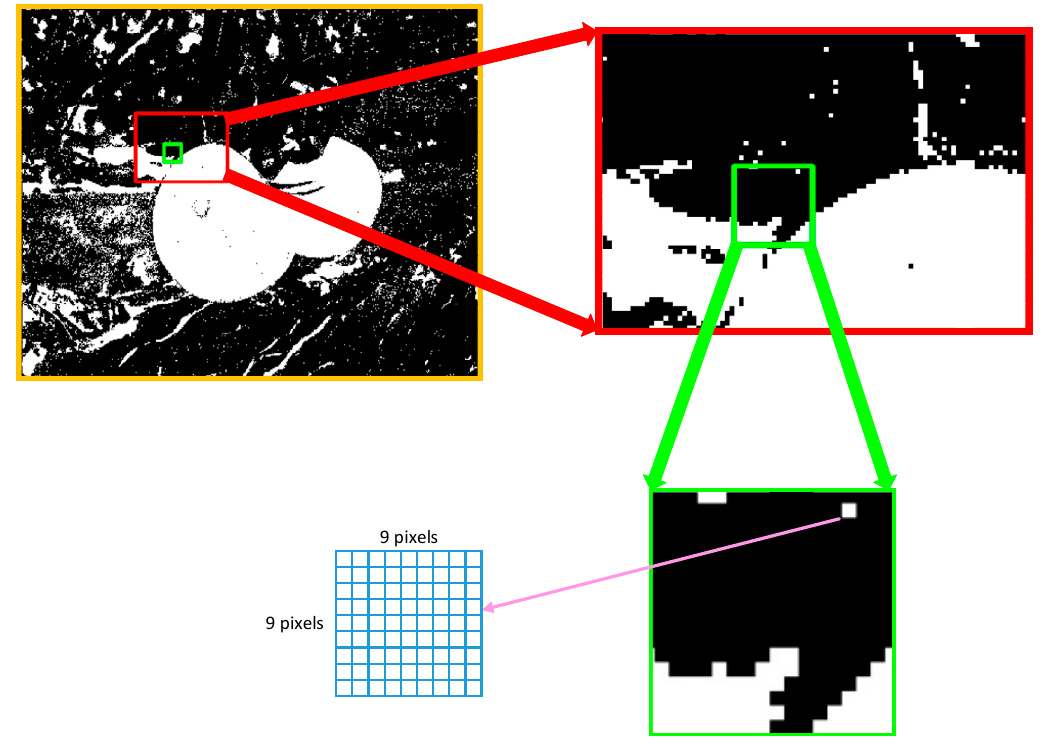
Figure 8. Demonstration of block segmentation for tomato recognition.